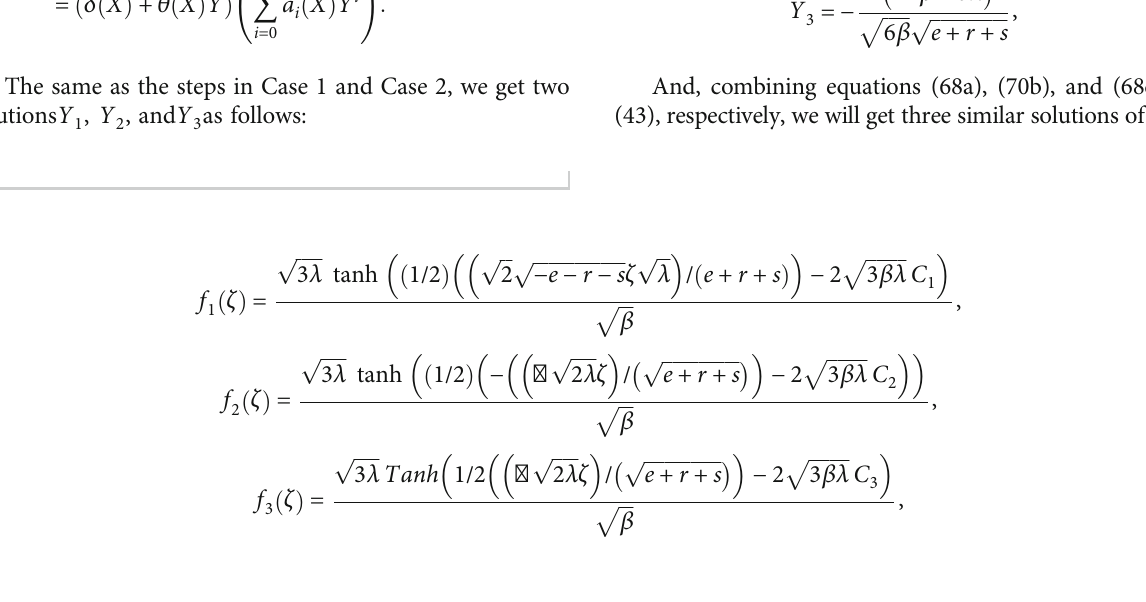
ffiffiffiffiffiffiffiffiffiffiffiffiffiffiffi